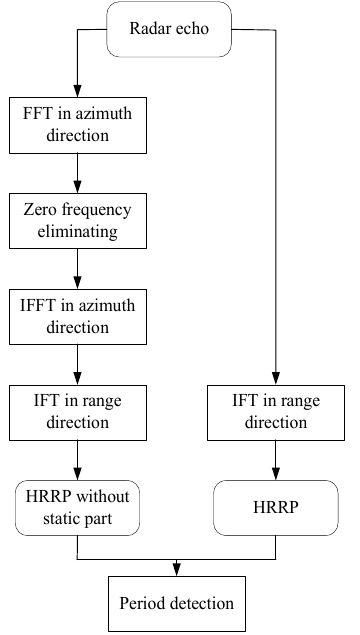
Figure 10. Gesture period acquisition.